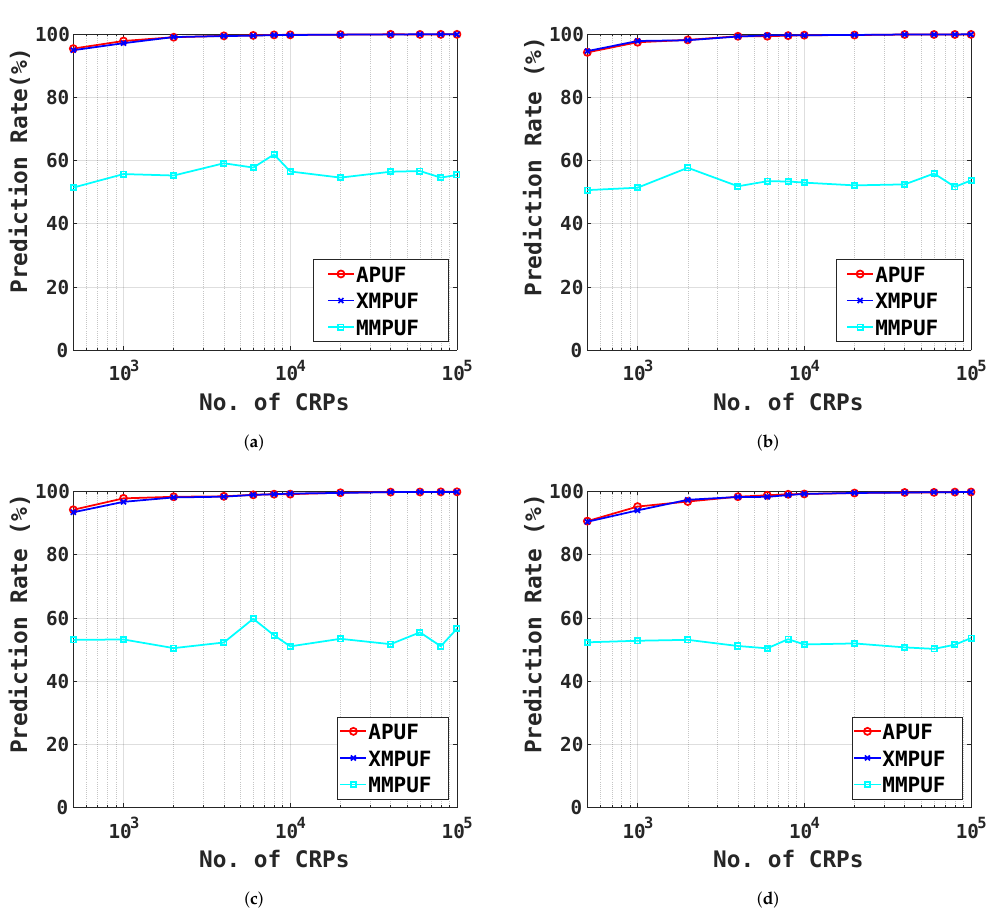
Figure 6. The prediction rates of the LR attacks for different PUF designs in various bit lengths: ( a ) 16 bit length, ( b ) 32 bit length, ( c ) 64 bit length, ( d ) 128 bit